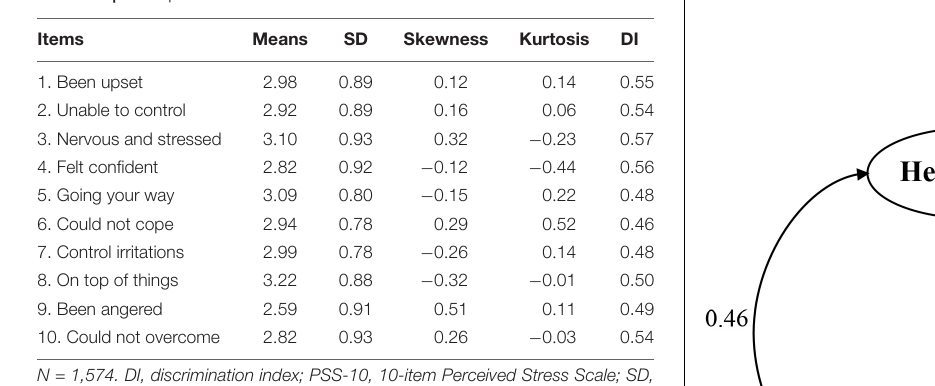
Compared to M2, although (cid:49) χ 2 ( p < 0.001) was significant, no significant changes occurred in the CFI ( (cid:49) CFI = 0.008) or RMSEA ( (cid:49) RMSEA = 0.001) based on the cutoff, which was 0.01 for (cid:49) CFI and (cid:49) RMSEA, suggesting that the means of the two constructs were equivalent across gender